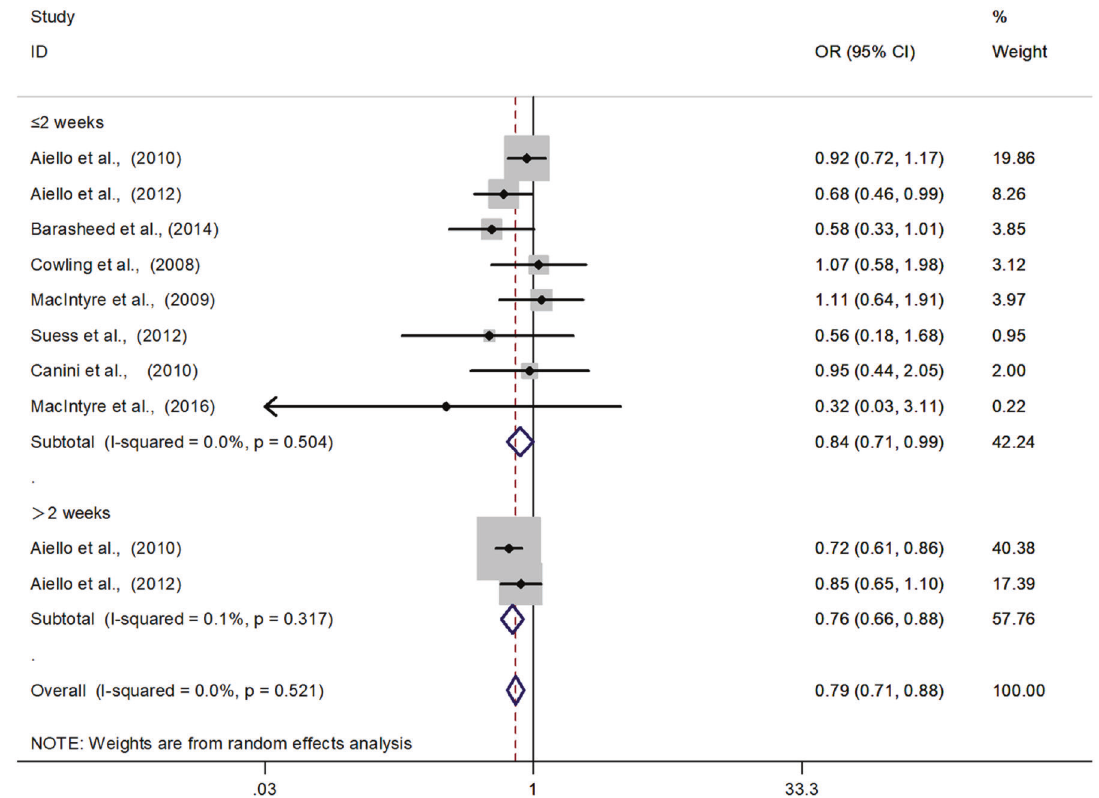
Fig. 2 Forest plots of meta-analysis to determine ef fi cacy of facemasks in reducing respiratory infection among the general population. There is a signi fi cant protective effect if the duration of facemask use was more than two weeks. The results are expressed as odds ratios (ORs) and 95% con fi dence intervals (95%